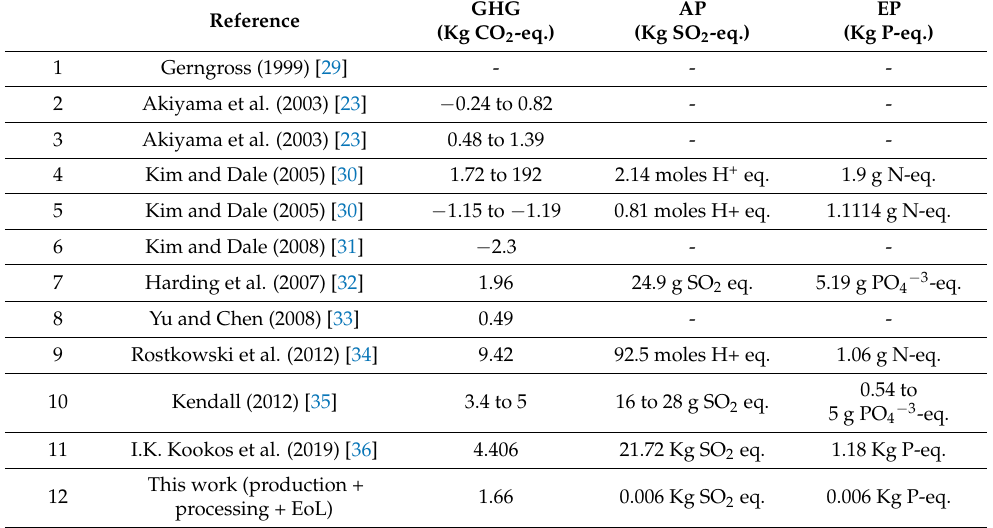
Table 3. Green House Gas (GHG) emissions, Acidification Potential (AP) and Eutrophication Potential (EP) results of previous studies on PHB production (all data are reported per kg of PHBH). The data obtained in the current study have been added in the last row.